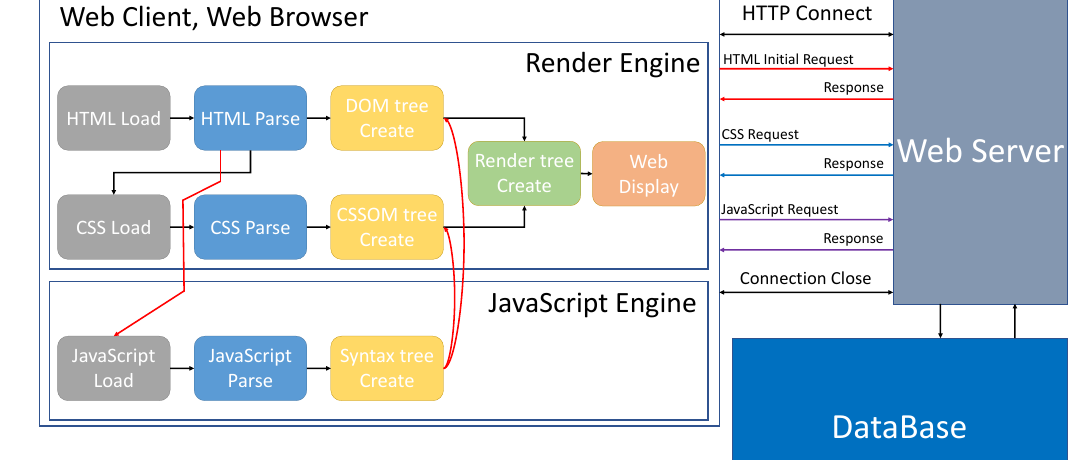
Figure 2. Web operation process [6].